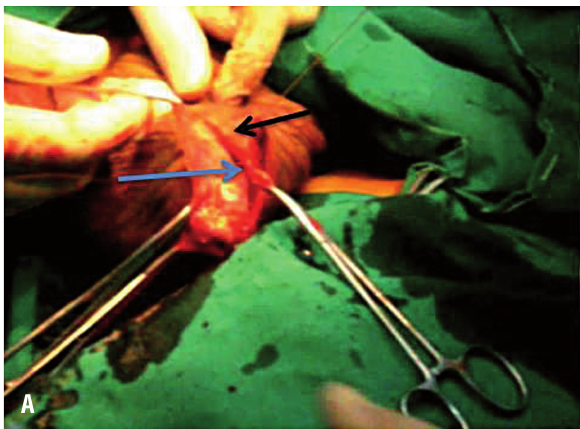
Figure 3B - An operative photograph showing completed eversion technique by suturing of the edge of the tunica to the Dartos and scrotal skin in an everted manner aiming to expose the visceral tunica toward scrotal